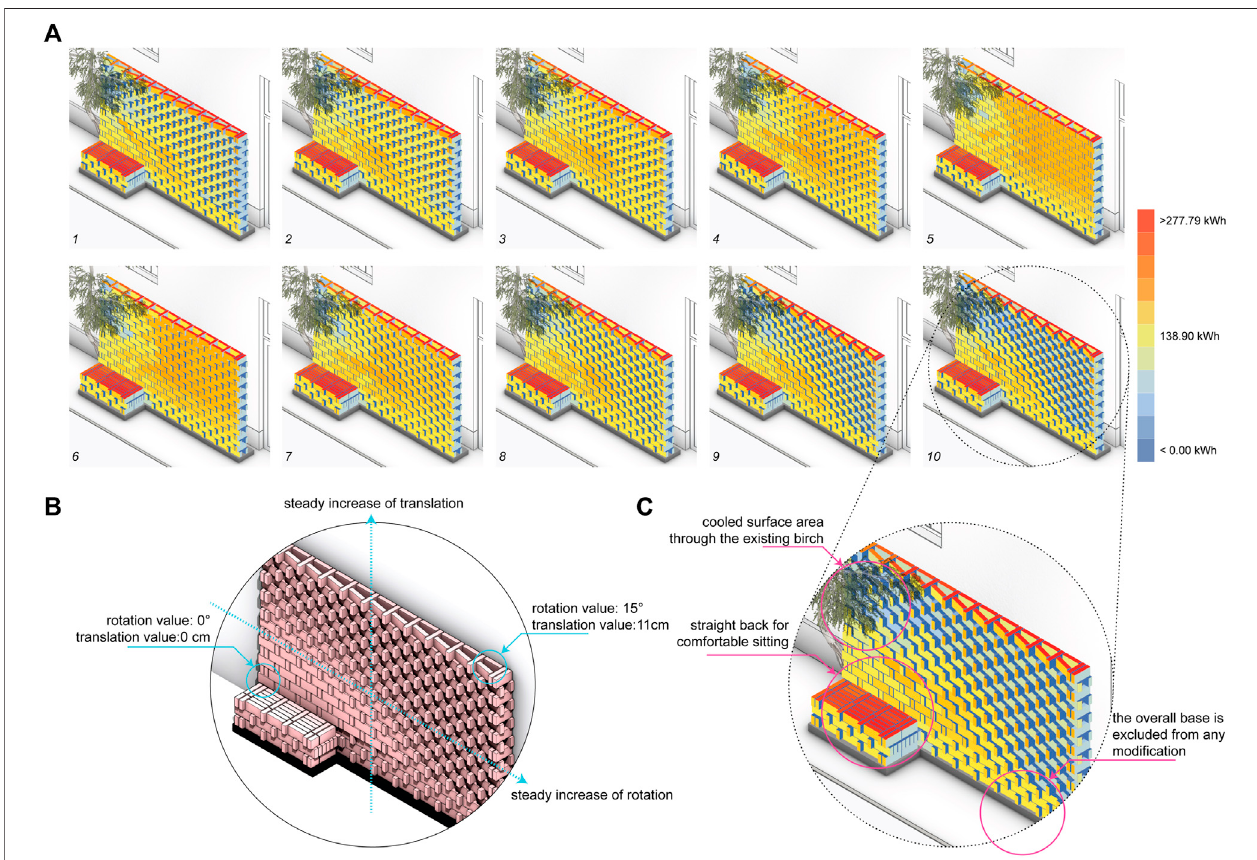
FIGURE6|(A) StartingfromthesolarradiationsimulationinLadybugToolsonaregularrat-trapbonded fl atbrickfacade(A5),differentcon fi gurationsbasedonan altering rotation and translation value of the shiner to the different surface temperatures and analyzed for the average time period extended from 01 June 2020, until